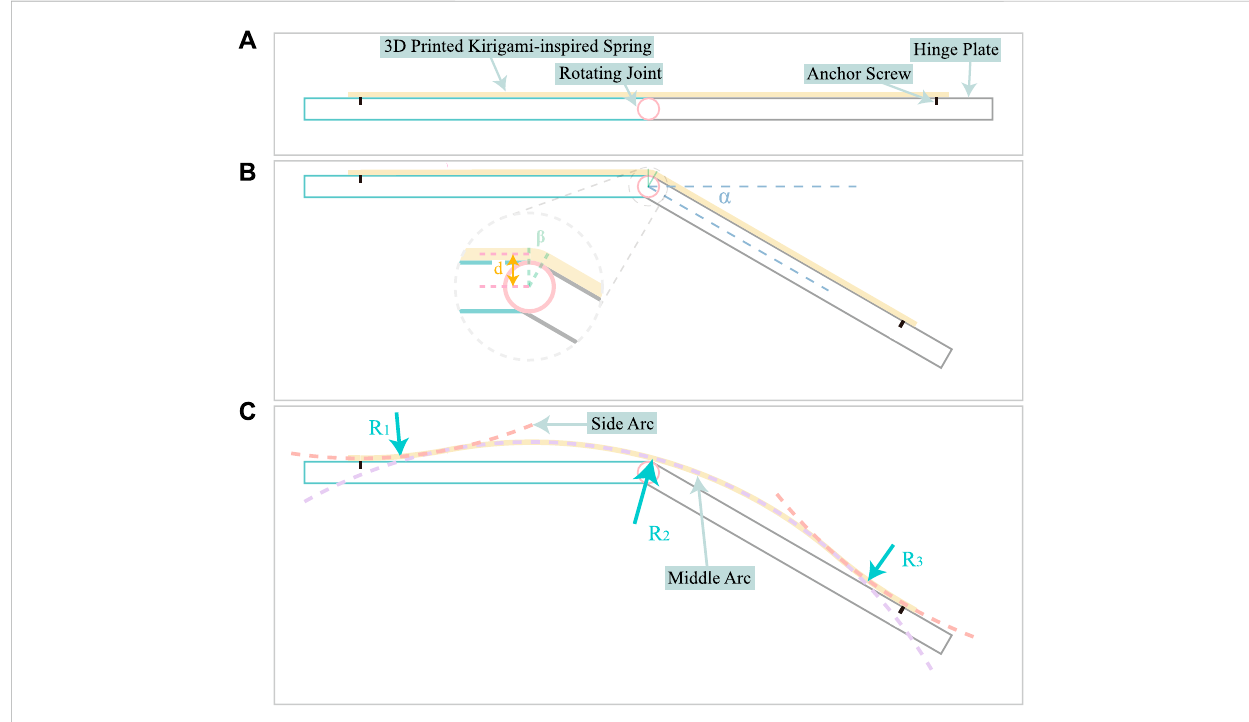
FIGURE 2 Kinematic description of kirigami-inspired elastic hinges. (A) Resting state of hinge; (B) Schematic diagram for smallest deformation ratio ( α = 30 ° ); (C) Schematic diagram for largest deformation ratio ( α = 30 ° ).